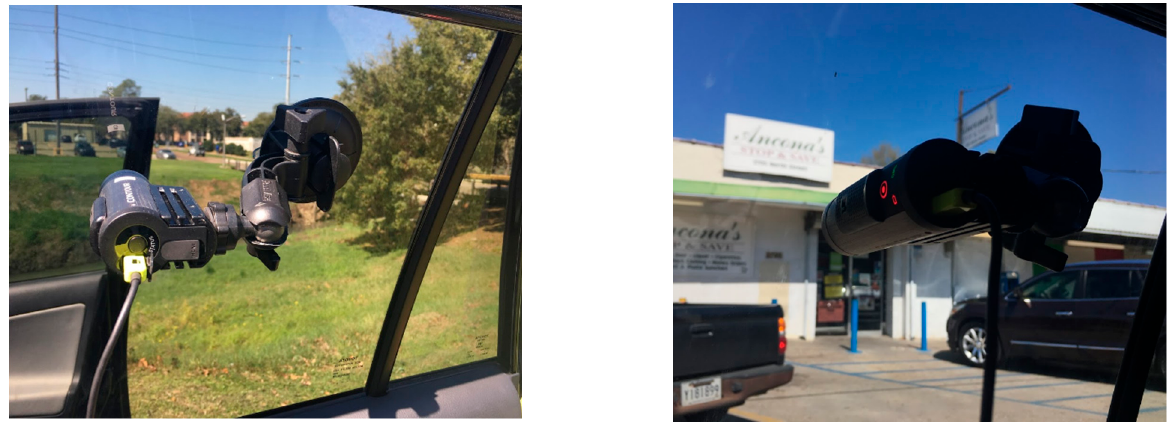
Figure 2. Examples of spatial video cameras mounted to the inside window of a vehicle. Geonarrative